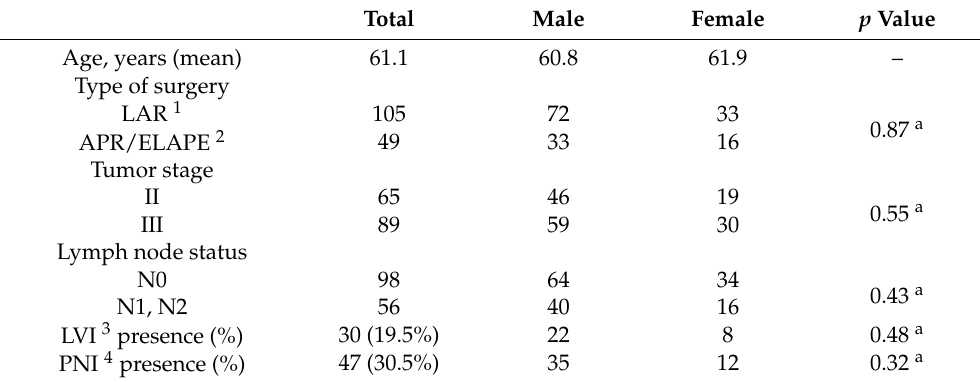
Table 1. Patient, surgery, and tumor data.